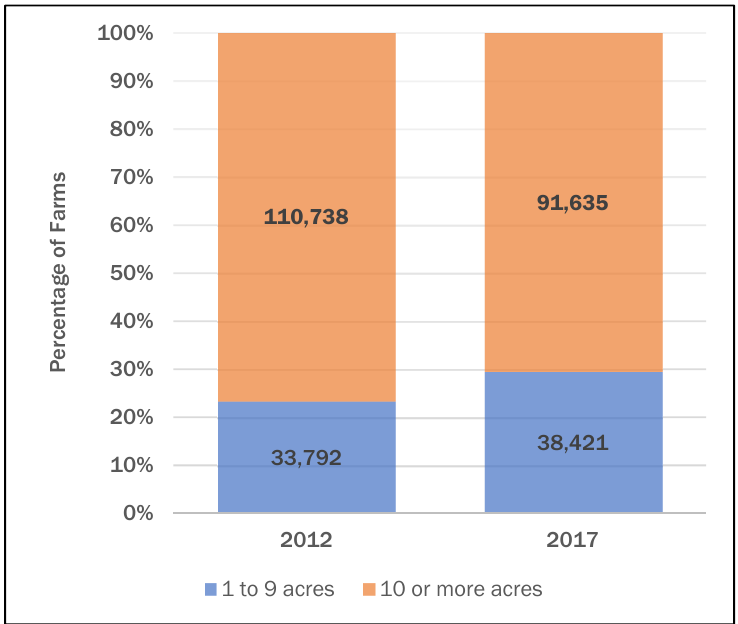
Figure 3. Comparison in the Size of Farms Selling Direct to Consumer (DTC) in 2012 and 2017 Censuses of Agriculture The number of DTC farms in each category appears on each section of the